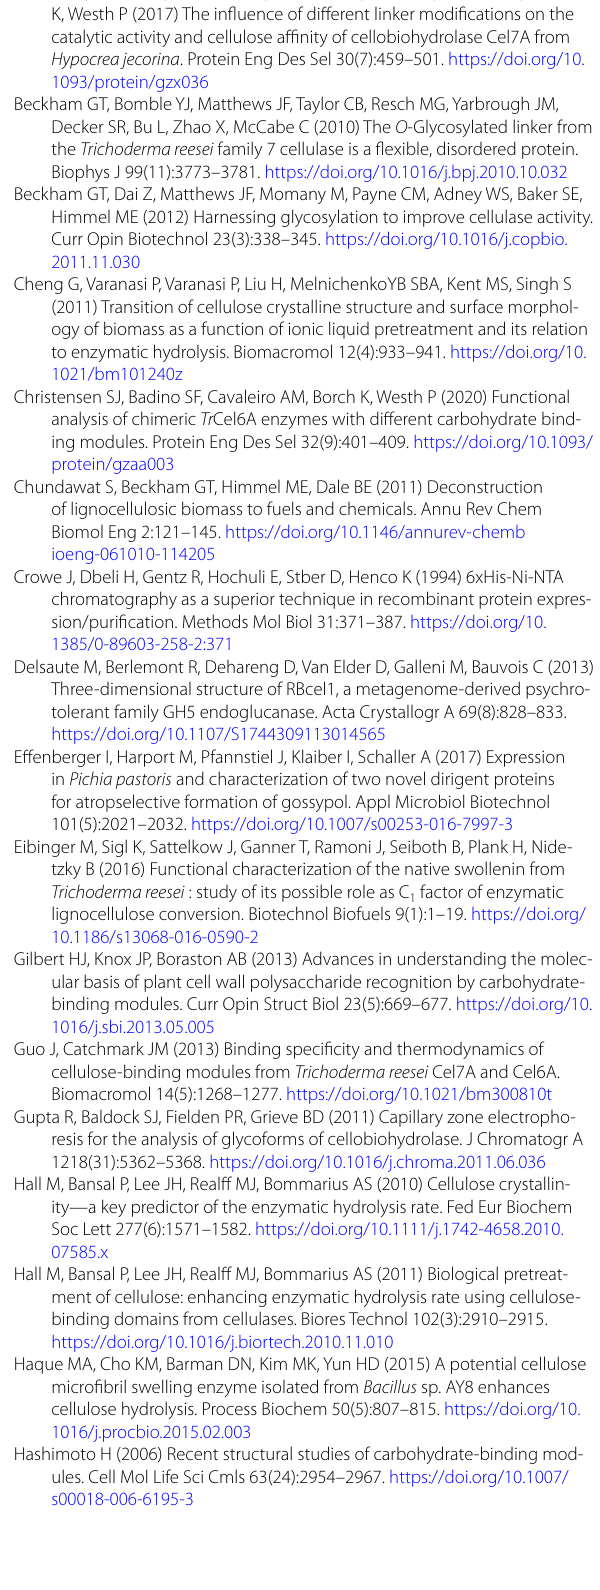
Fig. S1 SDS-PAGE analysis of Ec-ArCel5 and Pp-ArCel5. M, molecular mass marker (in kilodaltons); lanes 1, Pp-ArCel5; lanes 2, Ec-ArCel5.